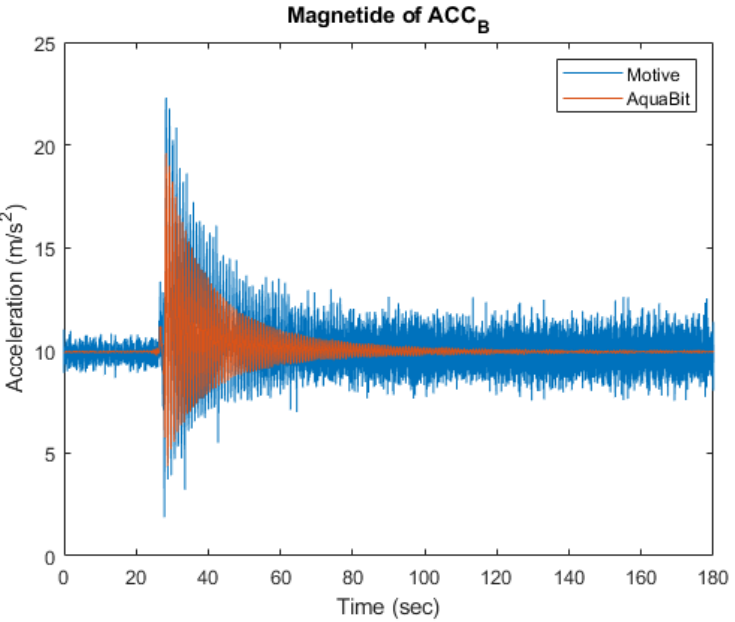
Figure 12. Time series of acceleration axis captured by the AquaBit device and the Motive MoCap system.